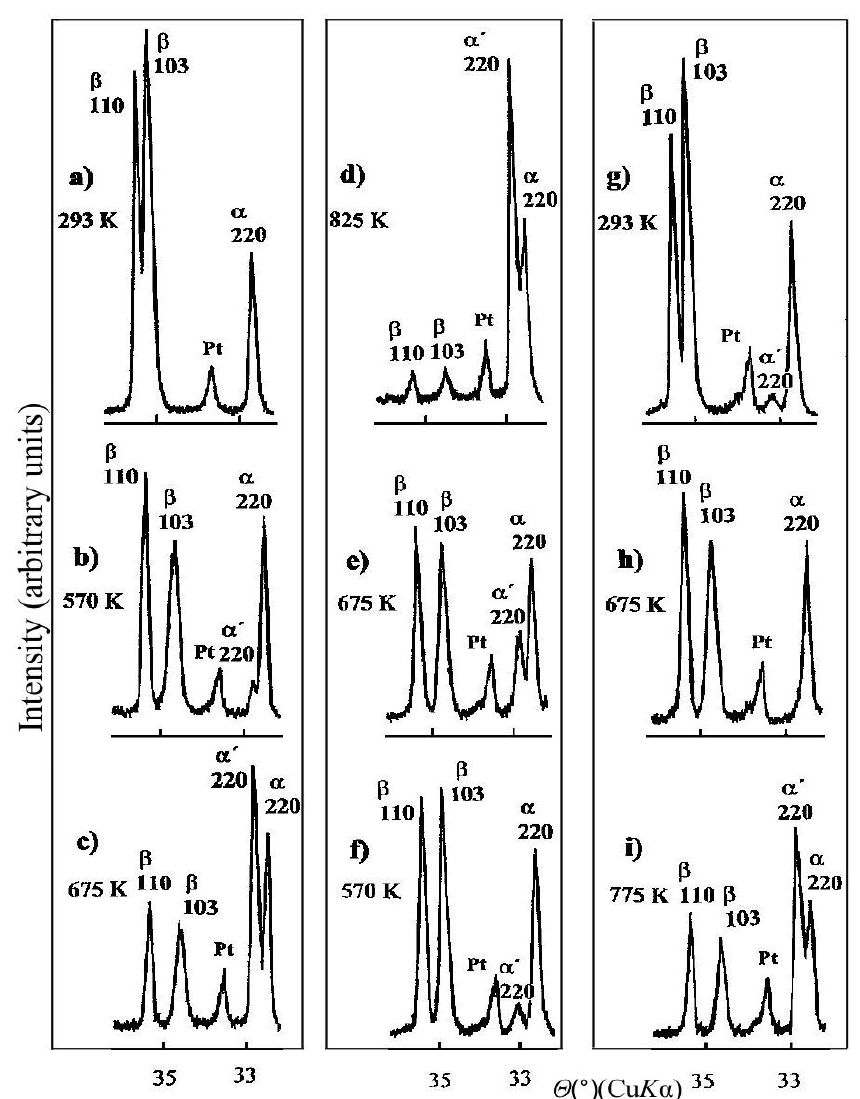
Figure 8. Characteristic parts of diffraction patterns at selected temperatures during the first and second heating and cooling cycles of the Al–Zn alloy with the initial content of Zn, x (Zn) = 0.48. The phases present in the alloy are: β(Zn) precipitates, α(M/β), α’, and α(M/β, α’). Prior to diffraction study at HT, the alloy was quenched from HT to RT and aged at RT for one week. Pt denotes the platinum heater of the sample [19].